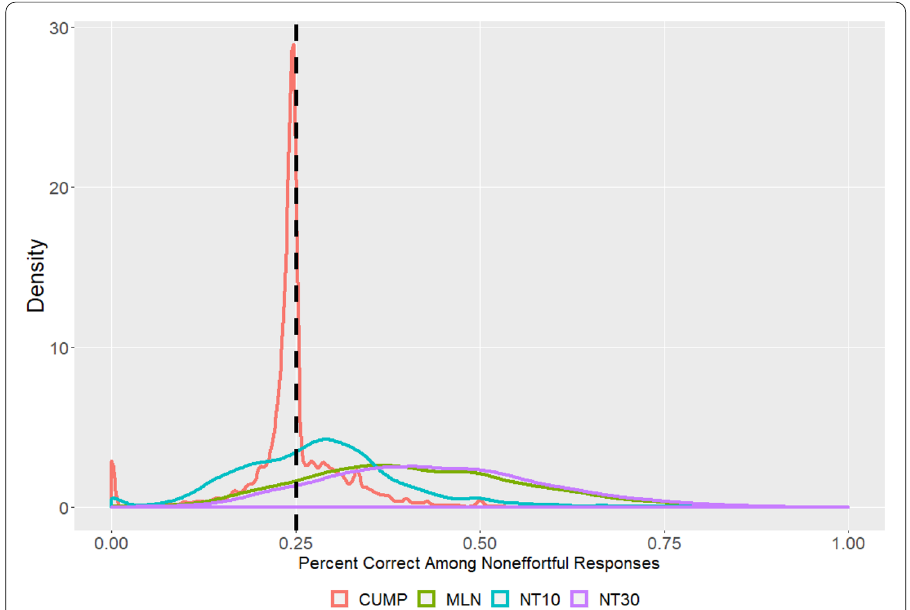
Fig. 1 Percent of correct responses among by item responses classified as noneffortful by threshold